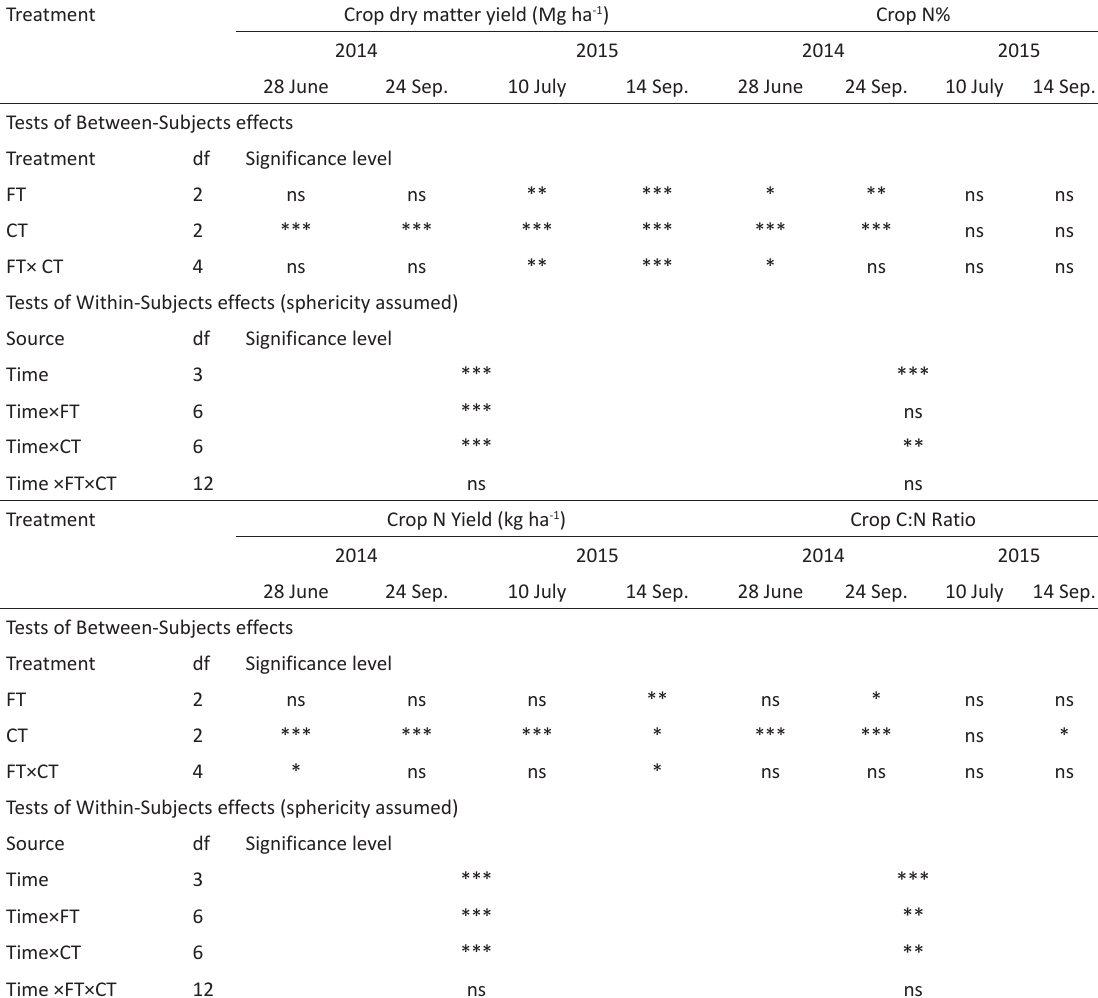
Table 2. Crop growth under different fertilizer and crop treatments